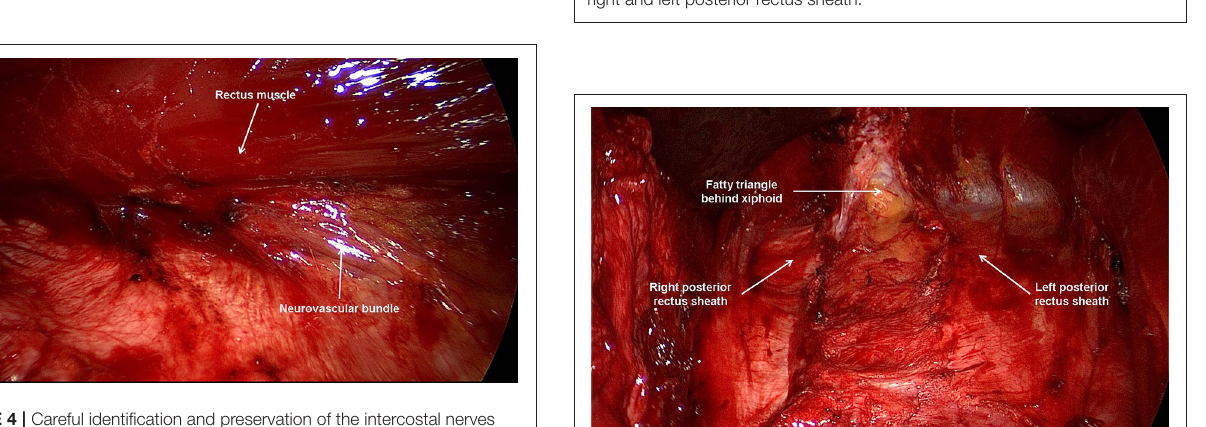
FIGURE 4 | Careful identification and preservation of the intercostal nerves and vessels are critical.